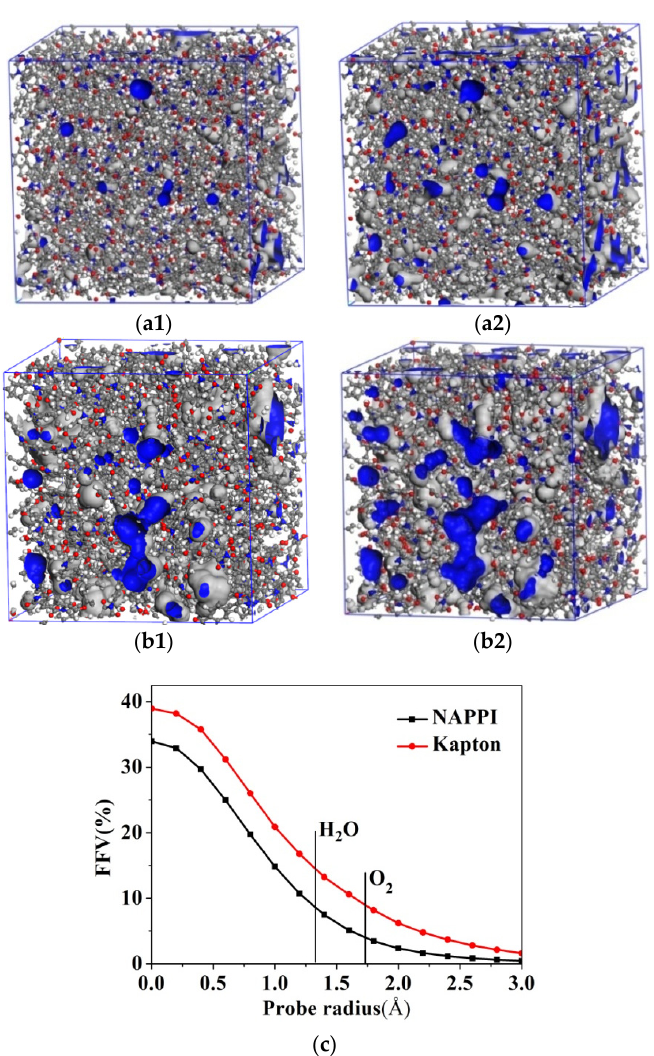
Figure 9. Morphologies of free volume in ( a1 , a2 ) NAPPI and ( b1 , b2 ) Kapton systems, the polymer networks are in gray, while the free volumes are denoted by blue with probe radius of 1.73 Å ( a1 , b1 ) and 1.325 Å ( a2 , b2 ), ( c ) FFV in NAPPI and Kapton as a function of probe radius.